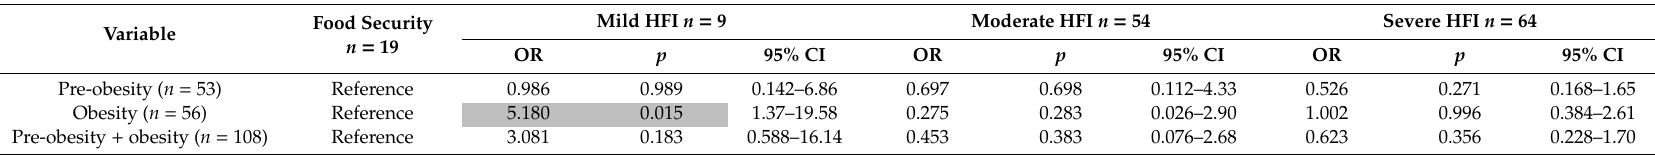
Table 3. Odds Ratios and 95% CI for the association between each obesity group and Household Food Insecurity (HFI) among migrant farm workers in Northwest